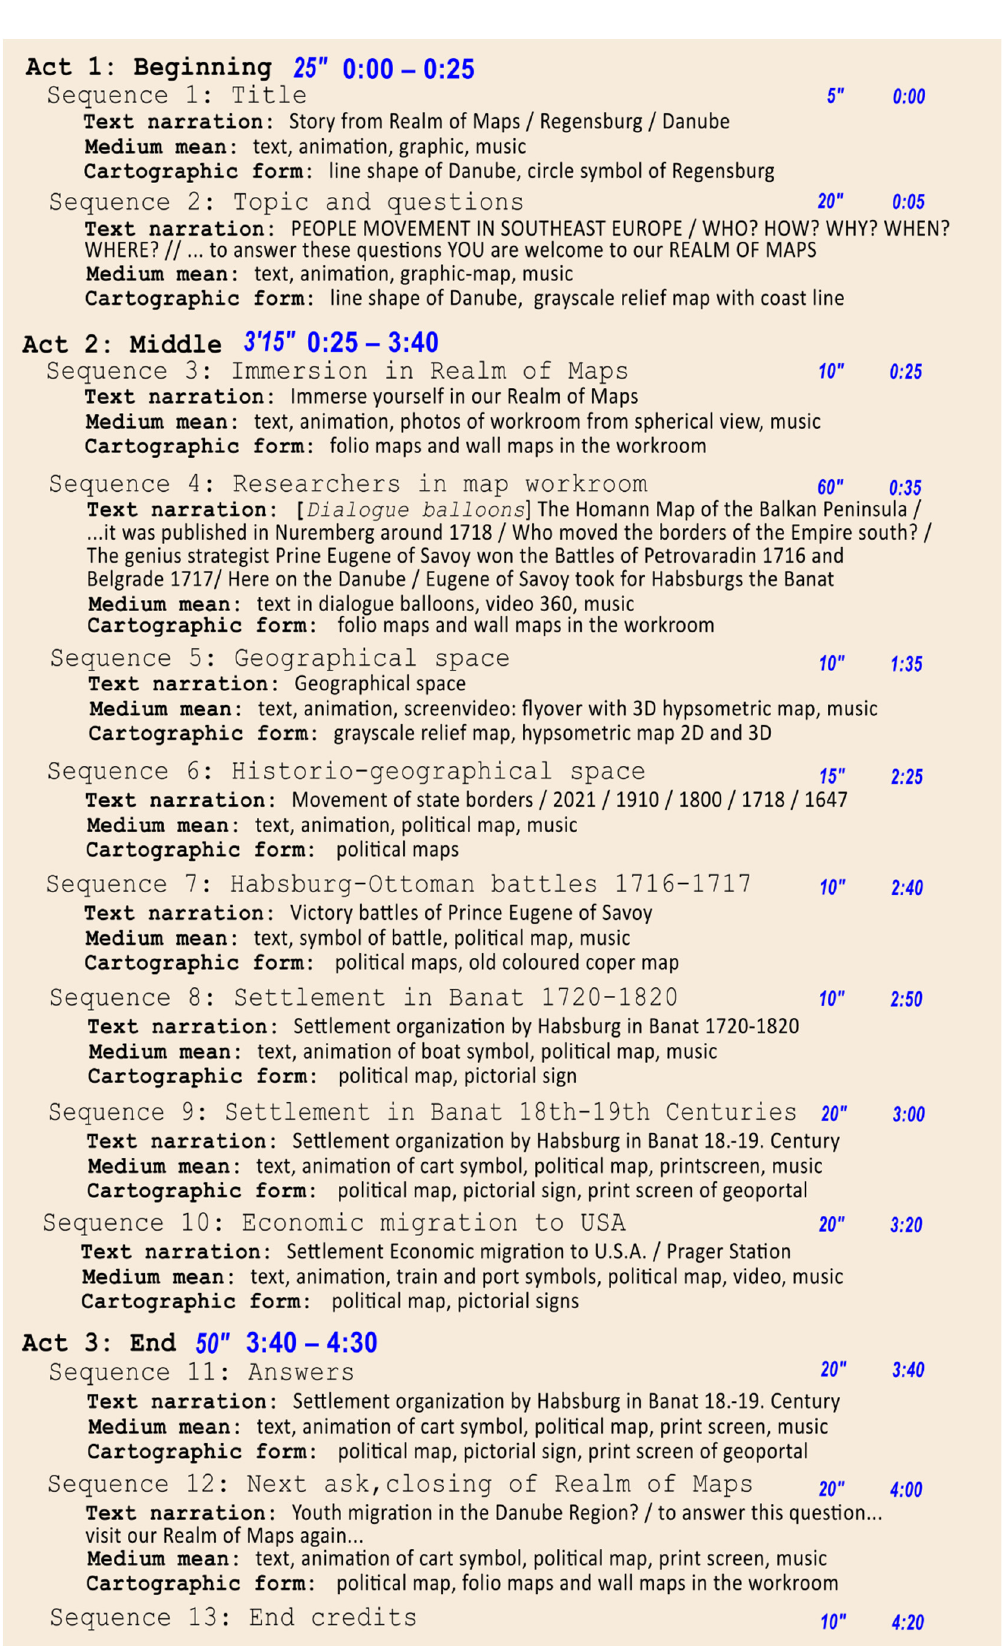
Figure 3. The short film script with ordered sequences in three acts with text narration, different medium means, and cartographic form, and with appropriate time proportions and matched time of duration for each sequence, with an accuracy of 5 s.